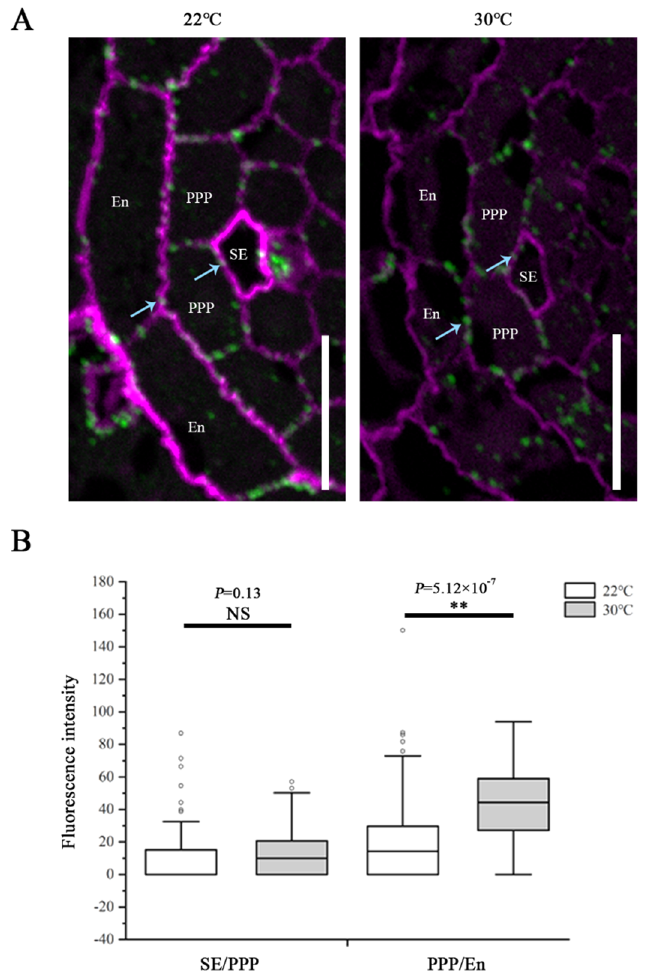
Figure 4. CalS8 is a bona fide callose synthase required for heat stress-induced callose deposition. ( A ) Immunolocalization of callose at plasmodesmata (blue arrows) at the SE–PPP and PPP–endodermis interfaces in the same region of the unloading domain (200 μ m upward of QC) in the root tips of cals8-1 at 24 h after transferred to 22 °C and 30 °C . Scale bars = 10 μ m. ( B ) Mean fluorescence intensity of the callose signals are calculated in ImageJ. In the box plots, the boxes indicate the first and third quartiles, and the whiskers indicate the minimum and maximum values. The black lines within the boxes indicate the median values. Outliers are shown as dots. ** p < 0.01 (two-tailed, two-sample t -test). NS, not significant.